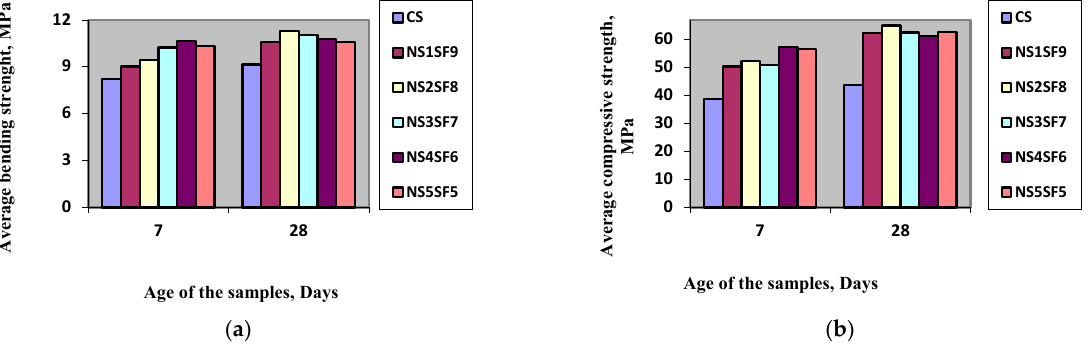
Figure 4. Compressive and bending strength of mortar containing nano-silica and micro-silica.